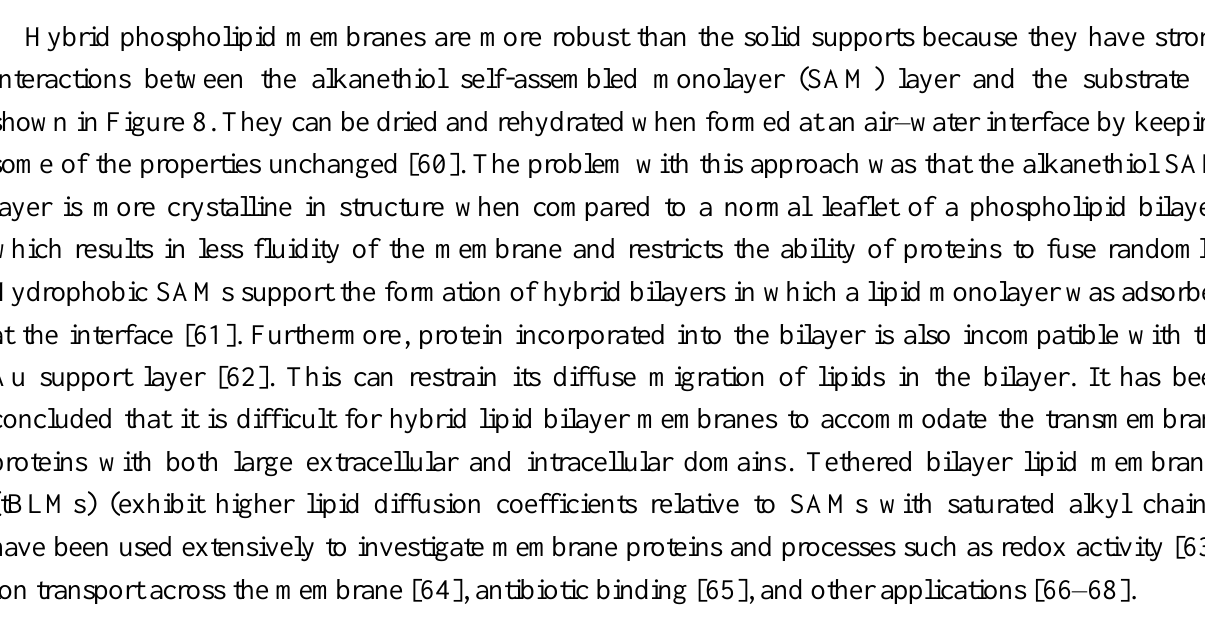
Figure 8. Illustration of a hybrid lipid membrane. ( a ) Alkanethiol SAM layer; ( b ) A single phospholipid monolayer on substrate; ( c ) Alkanethiol SAM layers arrange themselves over the gold surface, providing single layer lipid